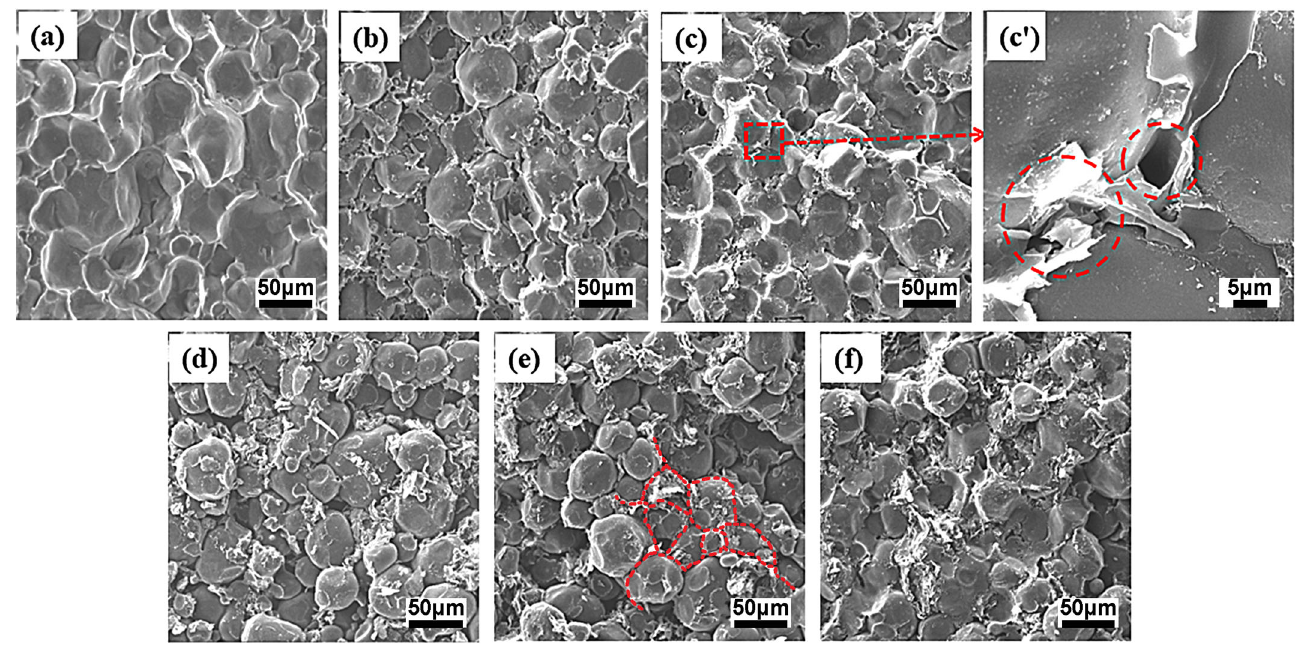
Figure 5. SEM images of PA6-GS composites of different GS contents: 0 wt% ( a ), 1 wt% ( b ), 3 wt% ( c ), 5 wt% ( d ), 7 wt% ( e ), and 9 wt% ( f ). A higher magnification of selected sections of part ( c ) is shown in part ( c’ ).